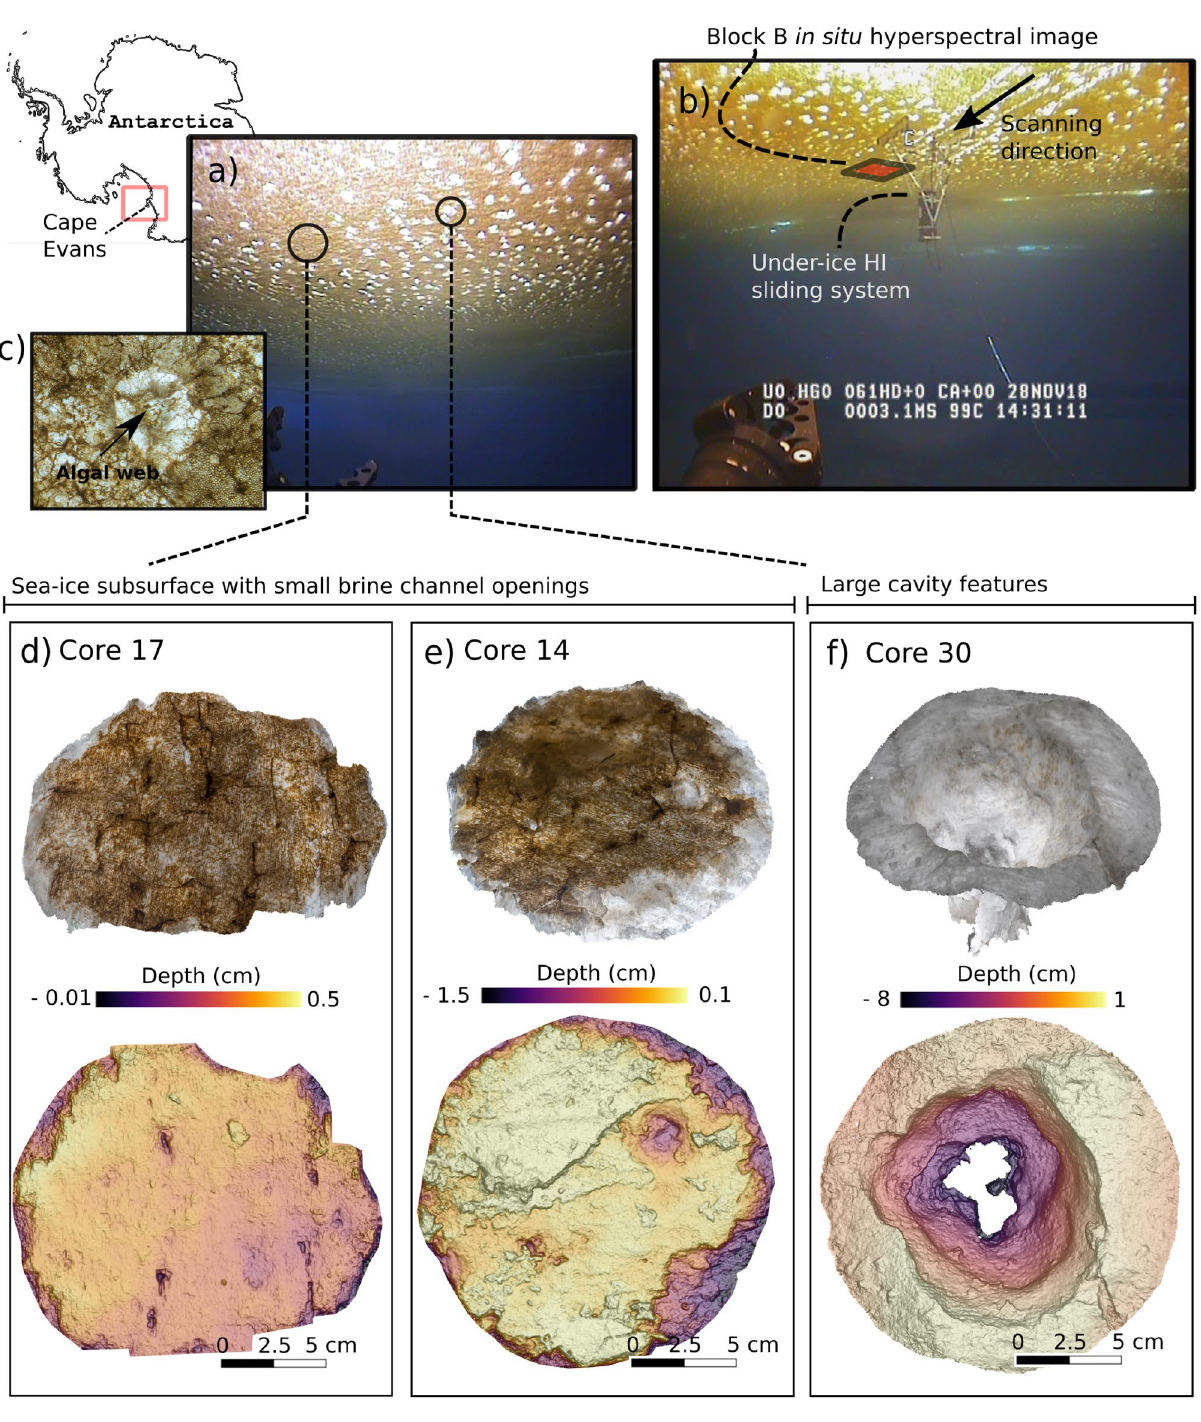
Figure 3. Illustration of a range of biophysical characteristics of the Cape Evans Antarctic fast-ice study site and under-ice hyperspectral image acquisition. ( a ) The distinct under-ice habitat encountered during Spring 2018 was characterized by scattered large cavity features varying widely in diameter and depth. ( b ) Block B under-ice image location and acquisition using the under-ice HI sliding system 38 . ( c ) one of the large cavity features from block B comprising a view of an algal-web like feature stretched on top of large ice cavity. These features on top of the cavity channels were a fairly common feature in the study area. ( d ), ( e ) and ( f ) display an oblique view of the bottom cores surface 3D models (top) and the complex microspatial variability of the under-ice structural features (below). Skeletal layer characteristic of land-fast sea ice is visible along with scale of observable brine channels and